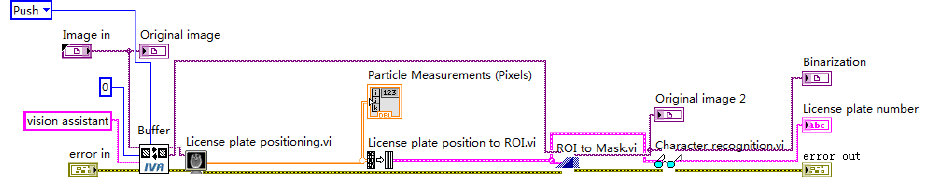
Figure 21. Main program block diagram of license plate recognition.